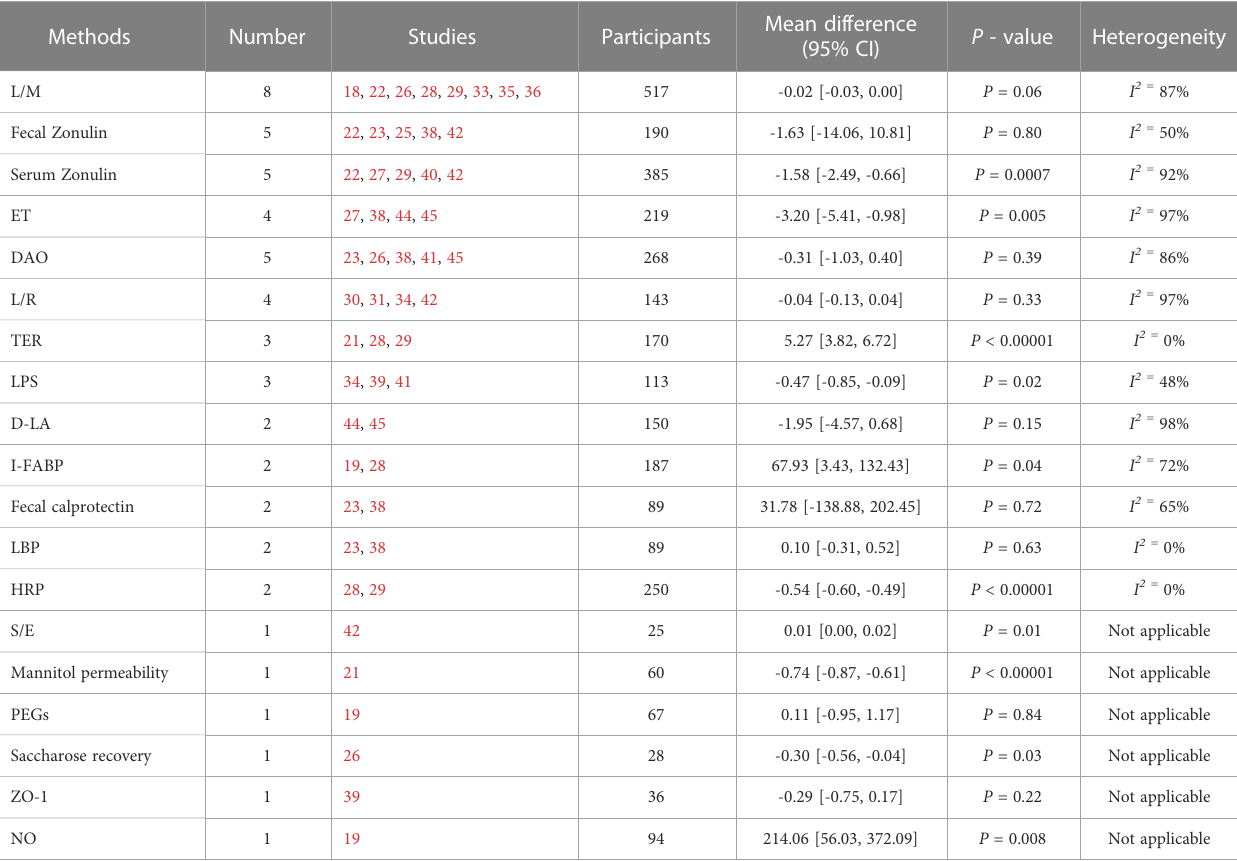
TABLE 2 Methods applied to assess the intestinal barrier function and the ef fi cacy of probiotics.